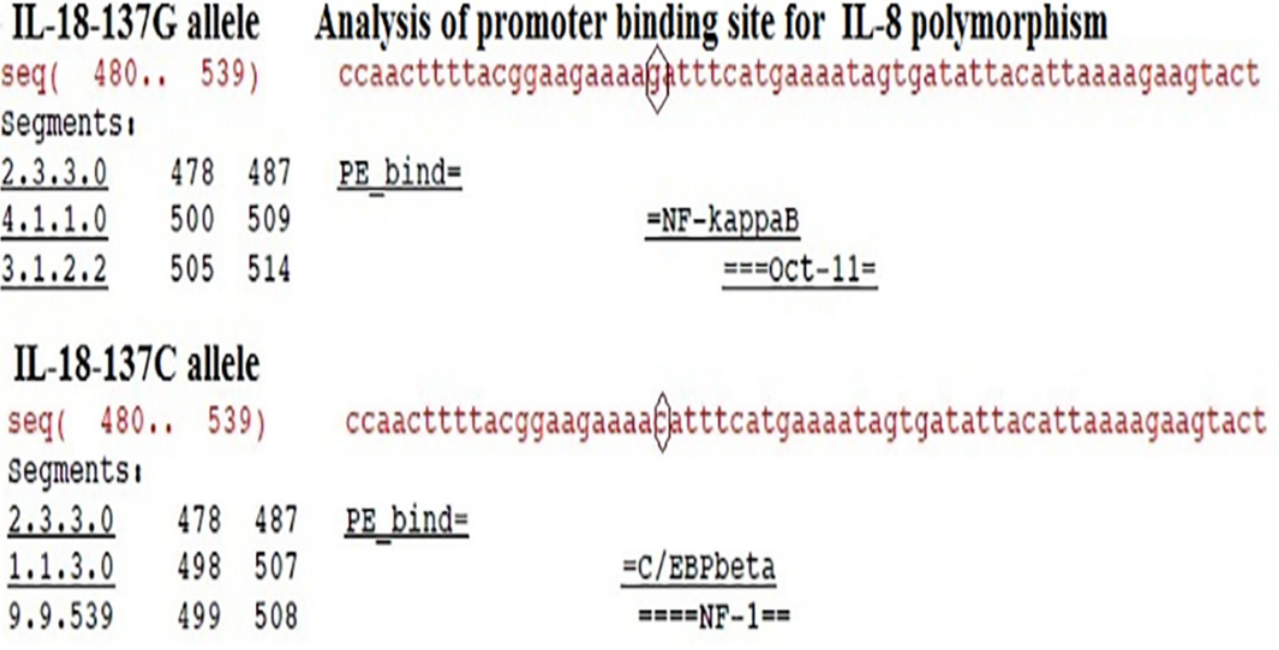
Fig 3. Analysis of Promoter binding site for IL -18-137 G/C